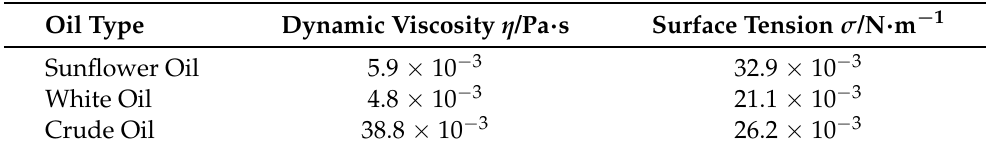
Table 1. Dynamic viscosity and surface tension of the sunflower oil, white oil, and crude oil at 20.0 ± 1.0 °C.